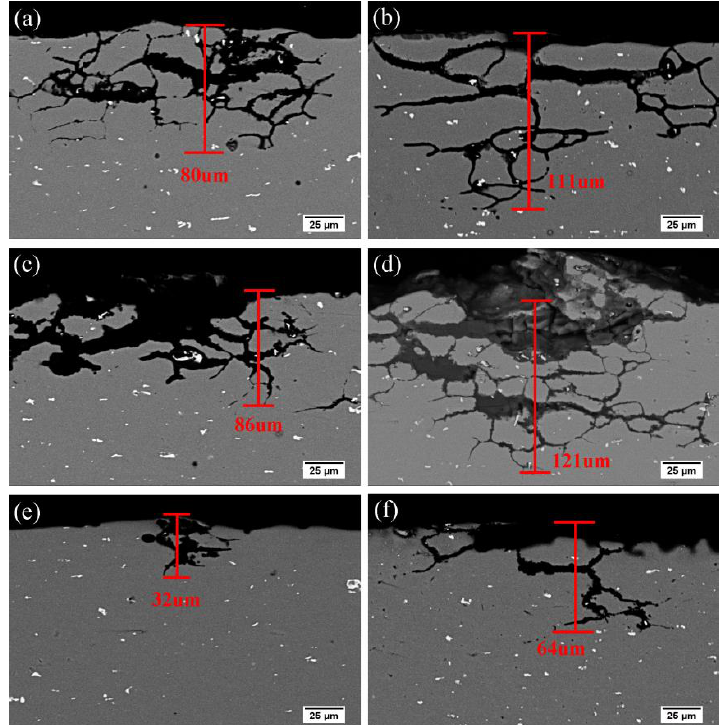
Figure 9. SEM morphologies of IGC and the maximum corrosion depth of alloy AA and AZ under different aging conditions at 170 °C ( a , c , e ) alloy AA, ( b , d , f ) alloy AZ, ( a , b ) under aged state, ( c , d ) peak aged state, and ( e , f ) over aged state.